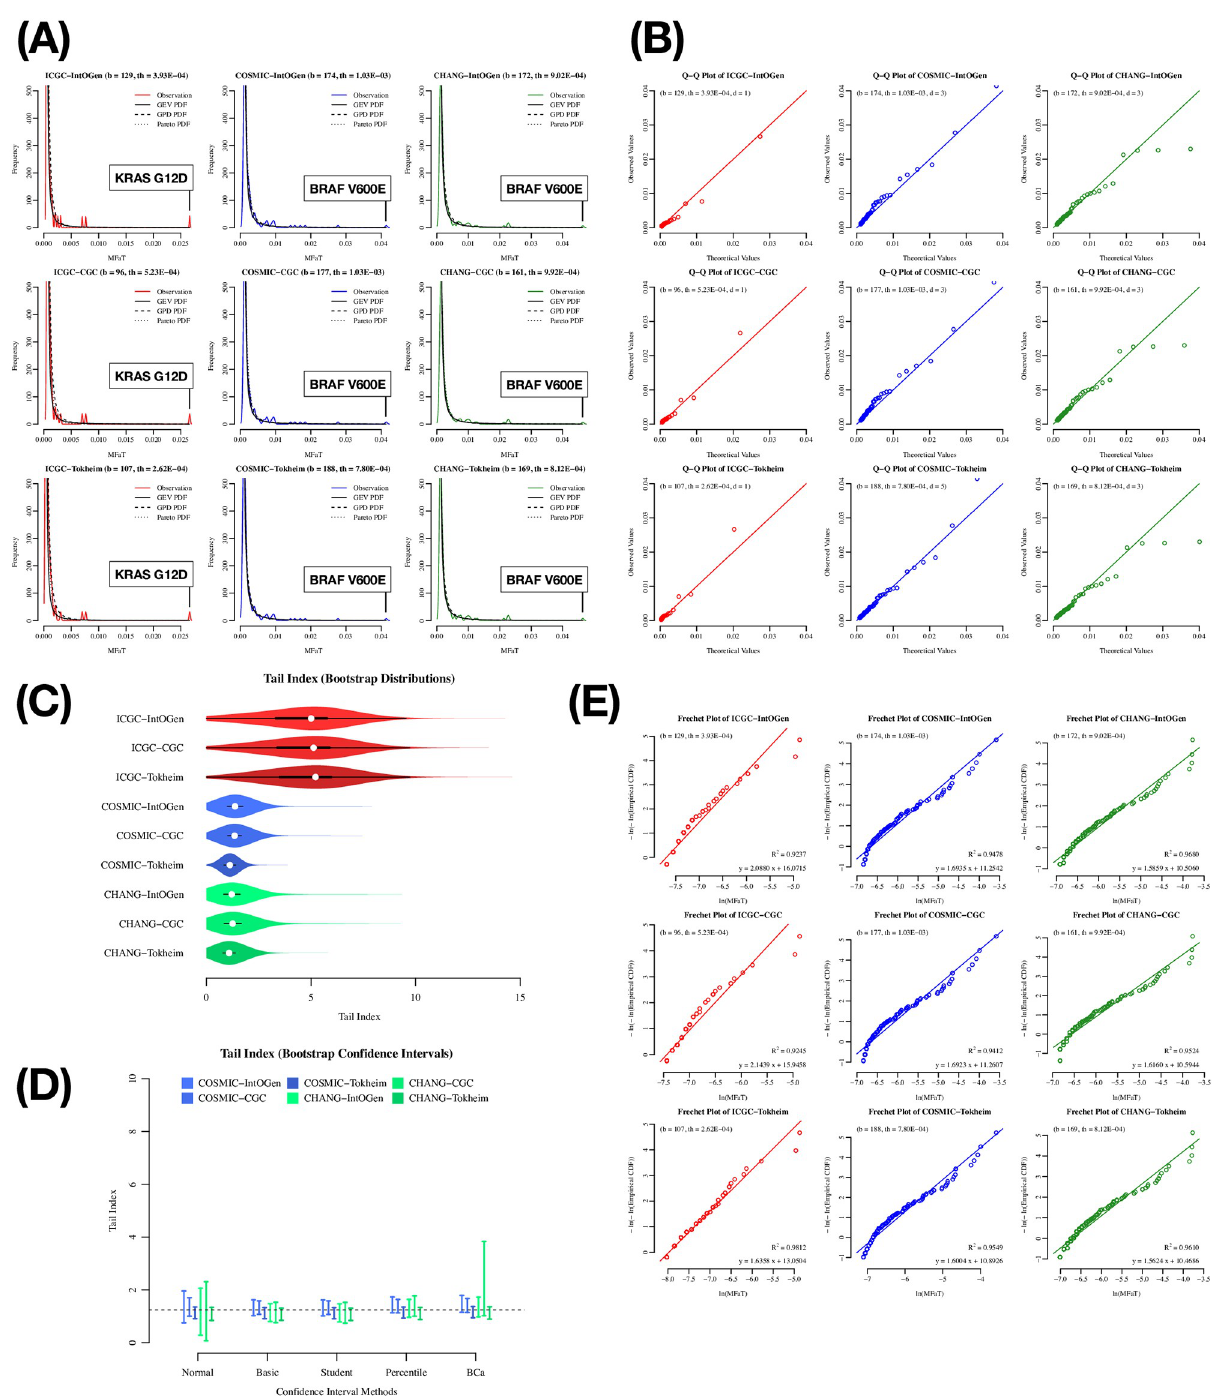
Fig 2. Exploratory plots on cancer driver mutation MFaTs in the total-tumor analysis with symbol-based filtering. In these figures, the “ICGC-IntOgen,” for example, denotes a set of mutations as an intersection of the ICGC mutations with the IntOgen driver-gene definition (i.e., symbol-based filtering)(for details, see Materials and methods). (A) Density plot of MFaTs. The colored solid line is probability density of observations, the black solid line is the probability density function (PDF) of GEV, and the dotted lines are the PDFs of the GPD and Pareto distributions. For each plot, a gene symbol and an amino acid substitution of a mutation with the highest MFaT value is shown in a box. (B) Q-Q plot of MFaTs. Here, “b” denotes the number of genomic sites of beneficial mutations considered, “th” denotes the effective threshold against MFaTs when selecting mutations according to ranks (for details, see Materials and methods), and “d” denotes the parameter in the normalization in the Q-Q plot. The straight line has the equation y = x . In the Q-Q plot, each point denotes a pair consisting of an observation and its corresponding theoretical value. (C) Bootstrap